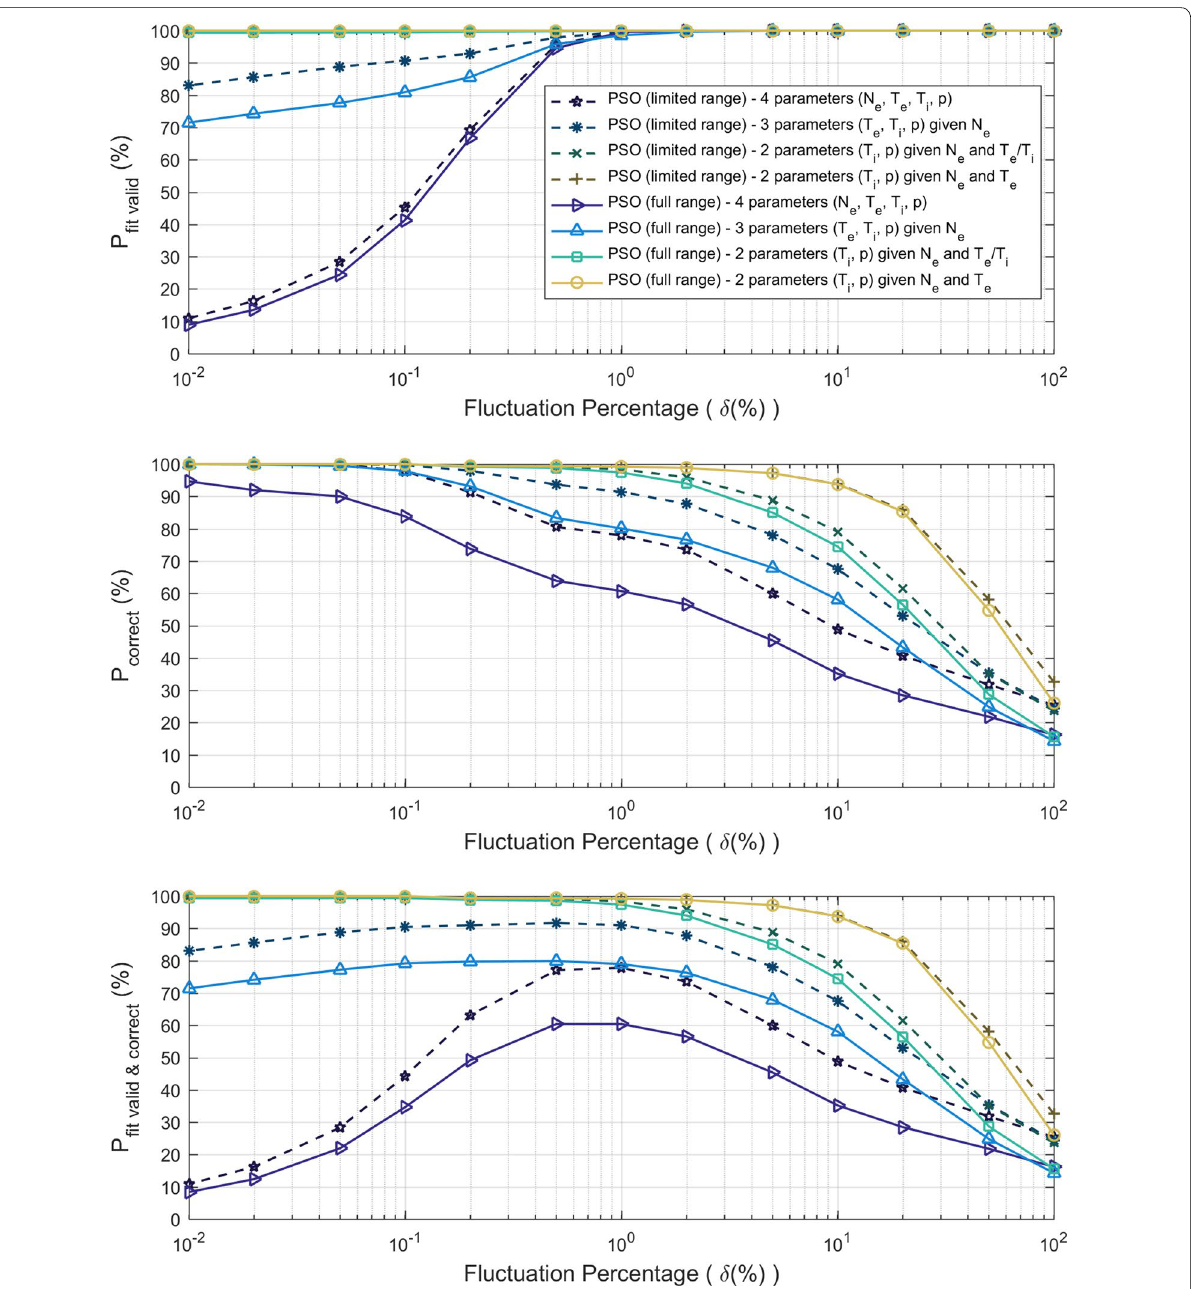
Fig. 5 Probability of convergence ( P fit valid ) and probability of “correct” estimation ( P correct ) (in percentage) obtained by simulations (dashed lines) with the limited search range of Wu et al. (2015) and (continuous lines) with the full ion composition search range ([0, 1]). Simulations were done at different signal fluctuation percentages ( δ( % ) ) fitting different combinations of known a priori plasma parameters from the plasma line: without a priori information, given N e , given N e and T e / T i , and given N e and T e